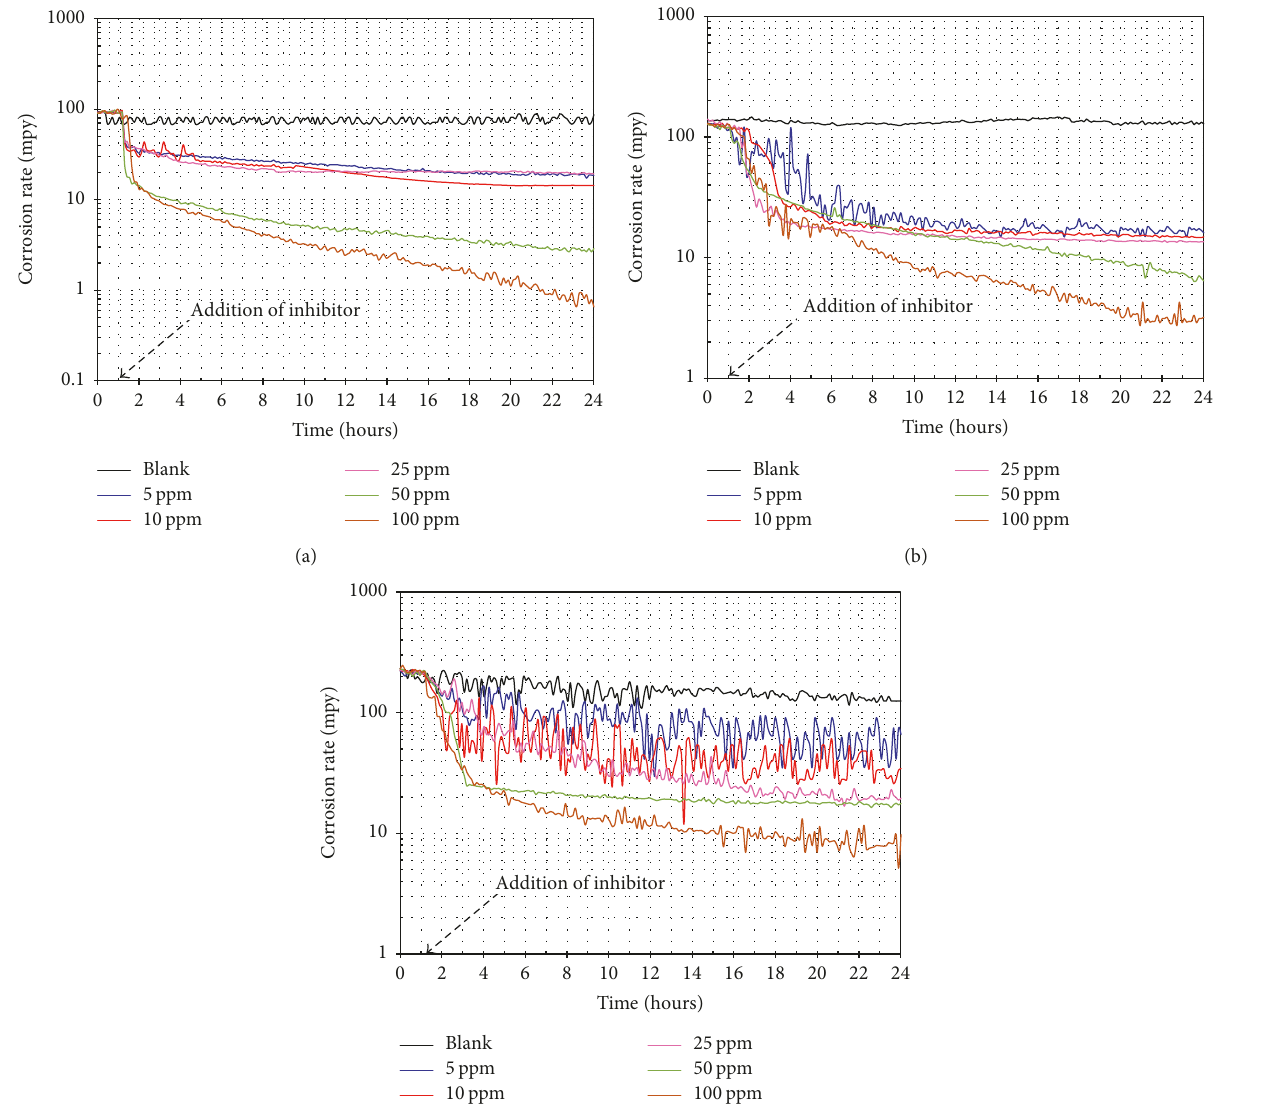
Figure 4: Variation of corrosion rate as determined by HDA (real-time monitoring) versus time for API X-70 steel exposed to CO 2 -saturated saline solution at different inhibitor concentration: (a) 30 ∘ C, (b) 50 ∘ C, and (c) 70 ∘